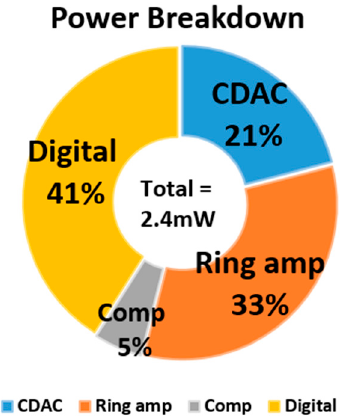
Figure 15. The measured SNDR versus input frequency.